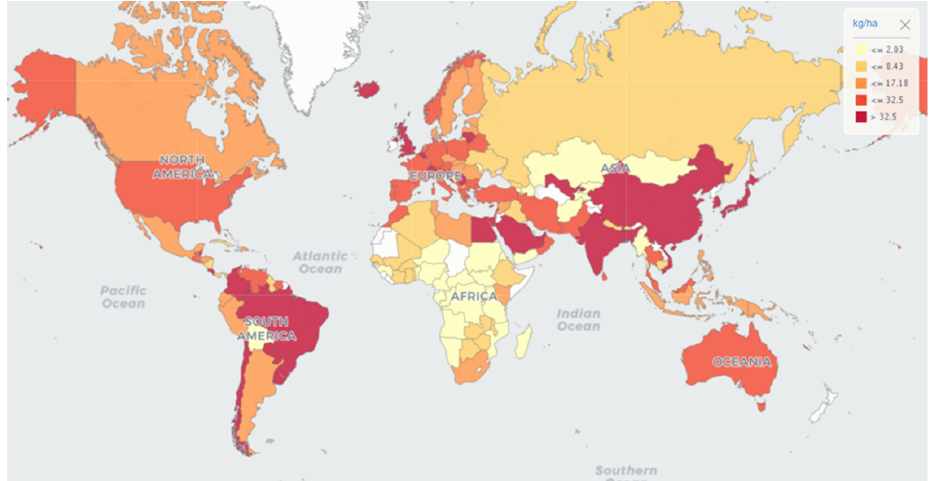
Figure 1. World map of the average nutrient phosphate P 2 O 5 application (kg/ha) from 2002 - 2016 (FAO 2019 http://www.fao.org/faostat/en/#data/EF/visualize